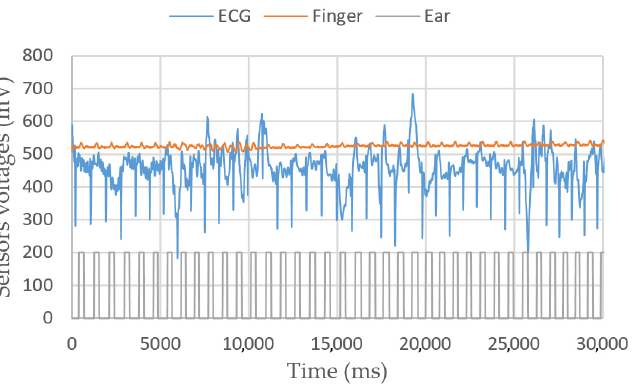
Figure 8. ECG, finger and ear heartbeat sensors’ voltages vs. time. In this second measurement, the target moves their finger between 5 and 10 s, their head between 15 and 20 s, their chest between 25 and 30 s.